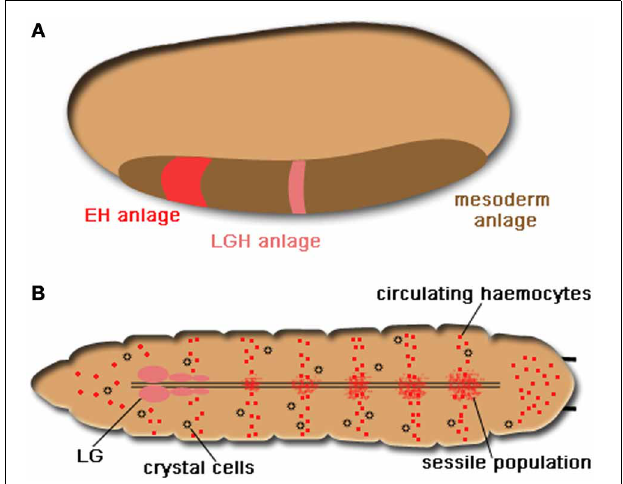
FIGURE 1 | Drosophila haematopoiesis. (A) The embryonic haematopoiesis. Two waves of haemocyte generation take place in Drosophila . During embryogenesis, haemocytes originate from the precephalic mesoderm as indicated in red in the region of mesoderm anlage (shown in brown), The pink region denotes the embryonic origin that will give rise to lymph gland haemocytes (LGH) in the larva. (B) Larval haematopoiesis. The LG (in pink) composes of the primary and secondary lobes and is located in the anterior end of the larva along the dorsal aorta. The sessile haemocyte population distributes diffusely along the segmental borders of the larva and consists of functional differentiated haemocytes and a few prohaemocytes with an embryonic origin (shown in the same red color). Until the end of the third star, circulating haemocytes including plasmatocytes and crystal cells (small black circles) are derived from the embryonic